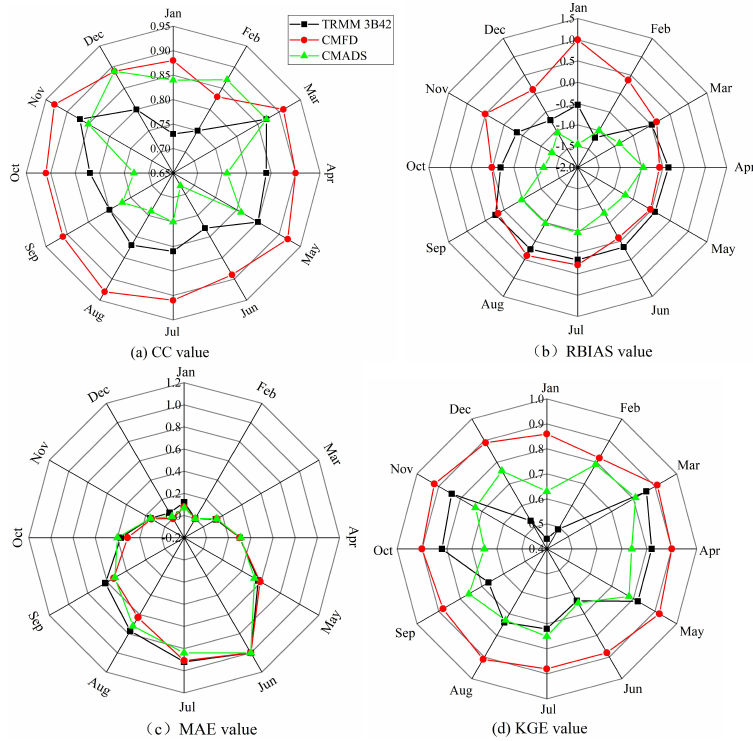
Figure 6. Radar chart of continuity evaluation indicators by